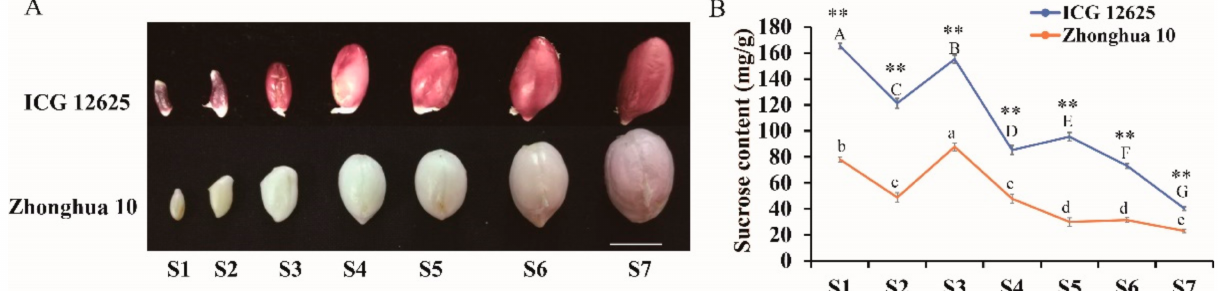
Figure 1. Phenotype differences between ICG 12625 and Zhonghua 10 at seven stages of development. ( A ) Seeds at seven different stages of development (S1–S7) in ICG 12625 and Zhonghua 10. The white solid line was a scale bar of 1 cm. ( B ) The changes in sucrose content in the seeds of two peanut varieties at different development stages (S1–S7). The value was an average sucrose content of three biological replications at each stage, and the error bar indicated standard error. The “**” represent extremely significant ( p < 0.01) differences between the two varieties according to the independent samples t -test. Different capital or small letters indicate that the sucrose content in the developing seeds of a variety was significant different ( p < 0.05) according to Bonferroni’s multiple comparison